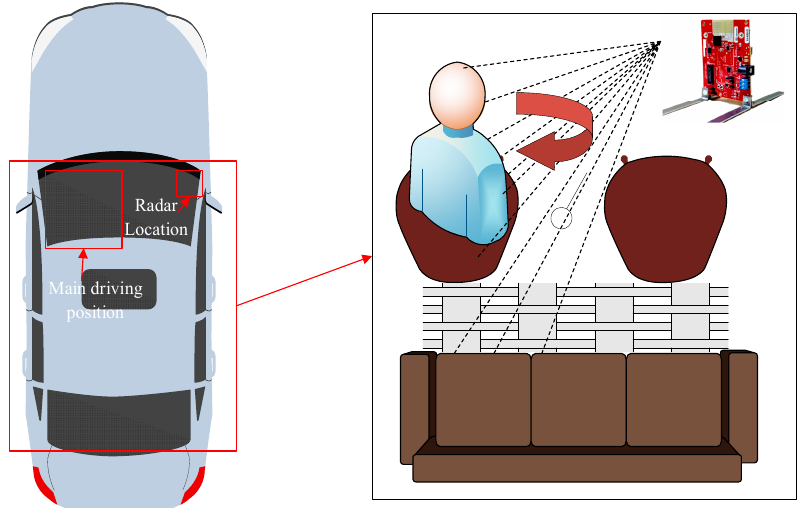
Figure 1. Target driver radar echo model.